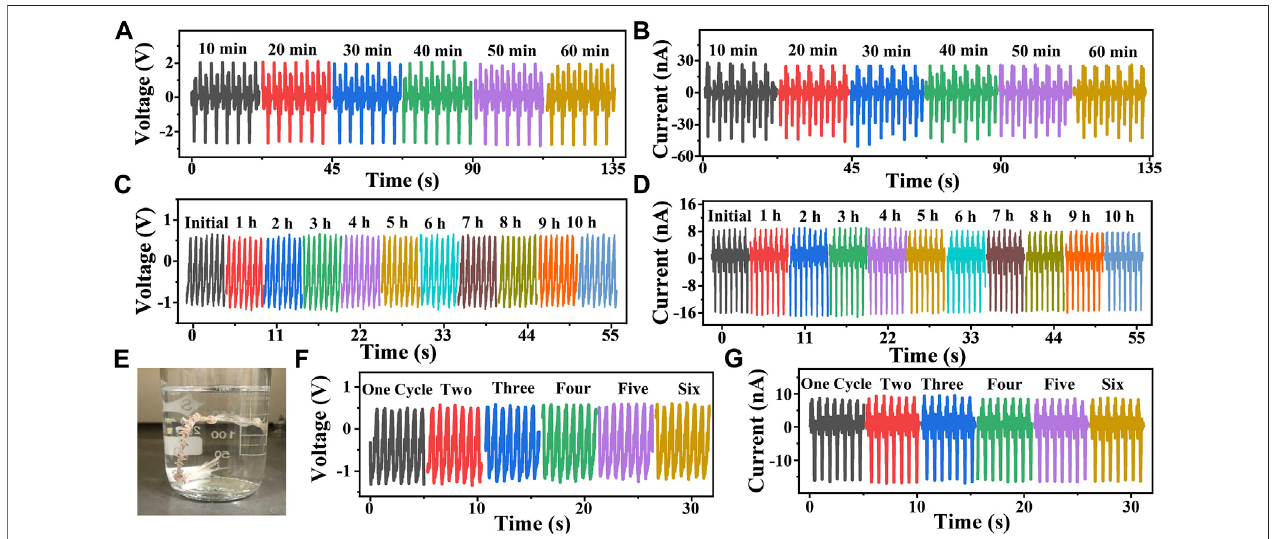
FIGURE 3 | Mechanical endurance of the TENG. (A,B) Voltage and current curves measured at 90% strain and 0.28 Hz after holding the TENG stretching at 90% strainfor different time periods. (C,D) Voltage and current curves measured with theTENG that waskept working at 70%strain and 0.14 Hz for 10 h. (E) Photographof the TENG while washing. (F – G) Voltage and current curves measured at 70% strain and 0.14 Hz after washing the TENG for different